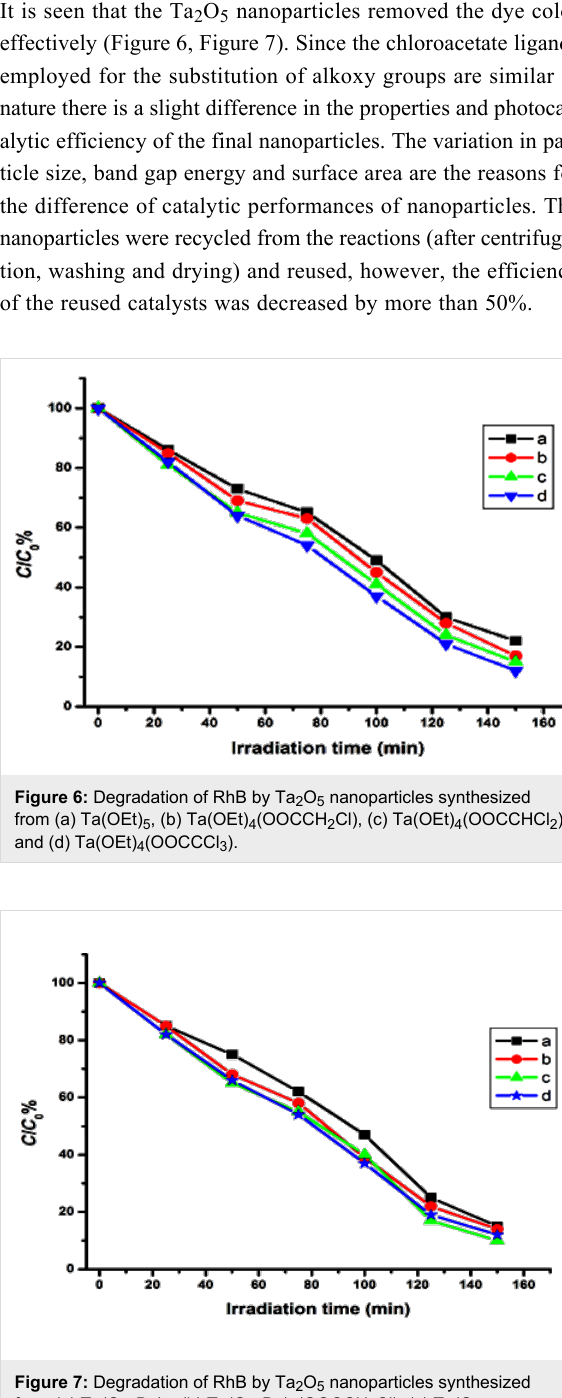
The mechanism of photocatalytic degradation of RhB is supposed to involve a series of carboxylation and de-ethylation reactions until the dye is decomposed into CO 2 and H 2 O. The proposed intermediates in degradation process are shown in Figure 8